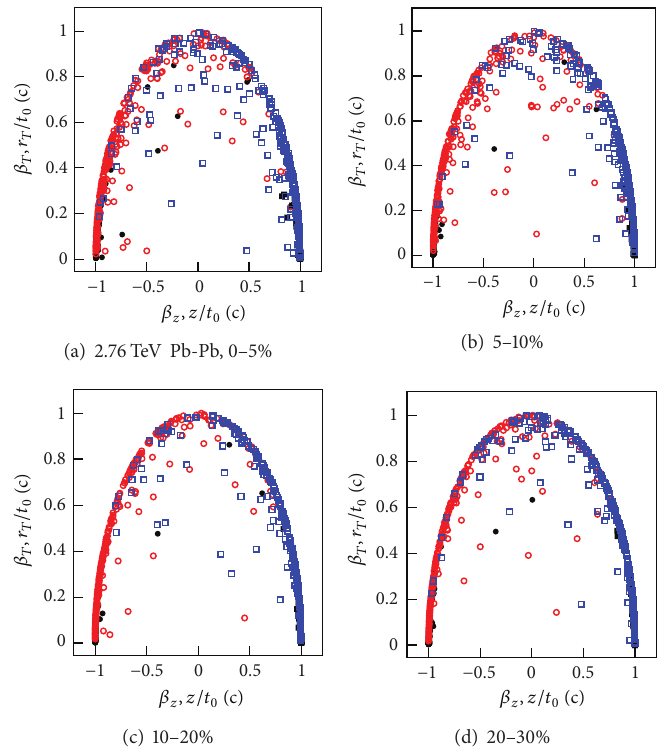
Figure 15: The same as for Figure 4, but showing the results in the space 𝛽 𝑇 − 𝛽 𝑧 (or 𝛽 𝑇 − 𝑧/𝑡 0 or 𝑟 𝑇 /𝑡 0 − 𝛽 𝑧 or 𝑟 𝑇 /𝑡 0 − 𝑧/𝑡 0 ).